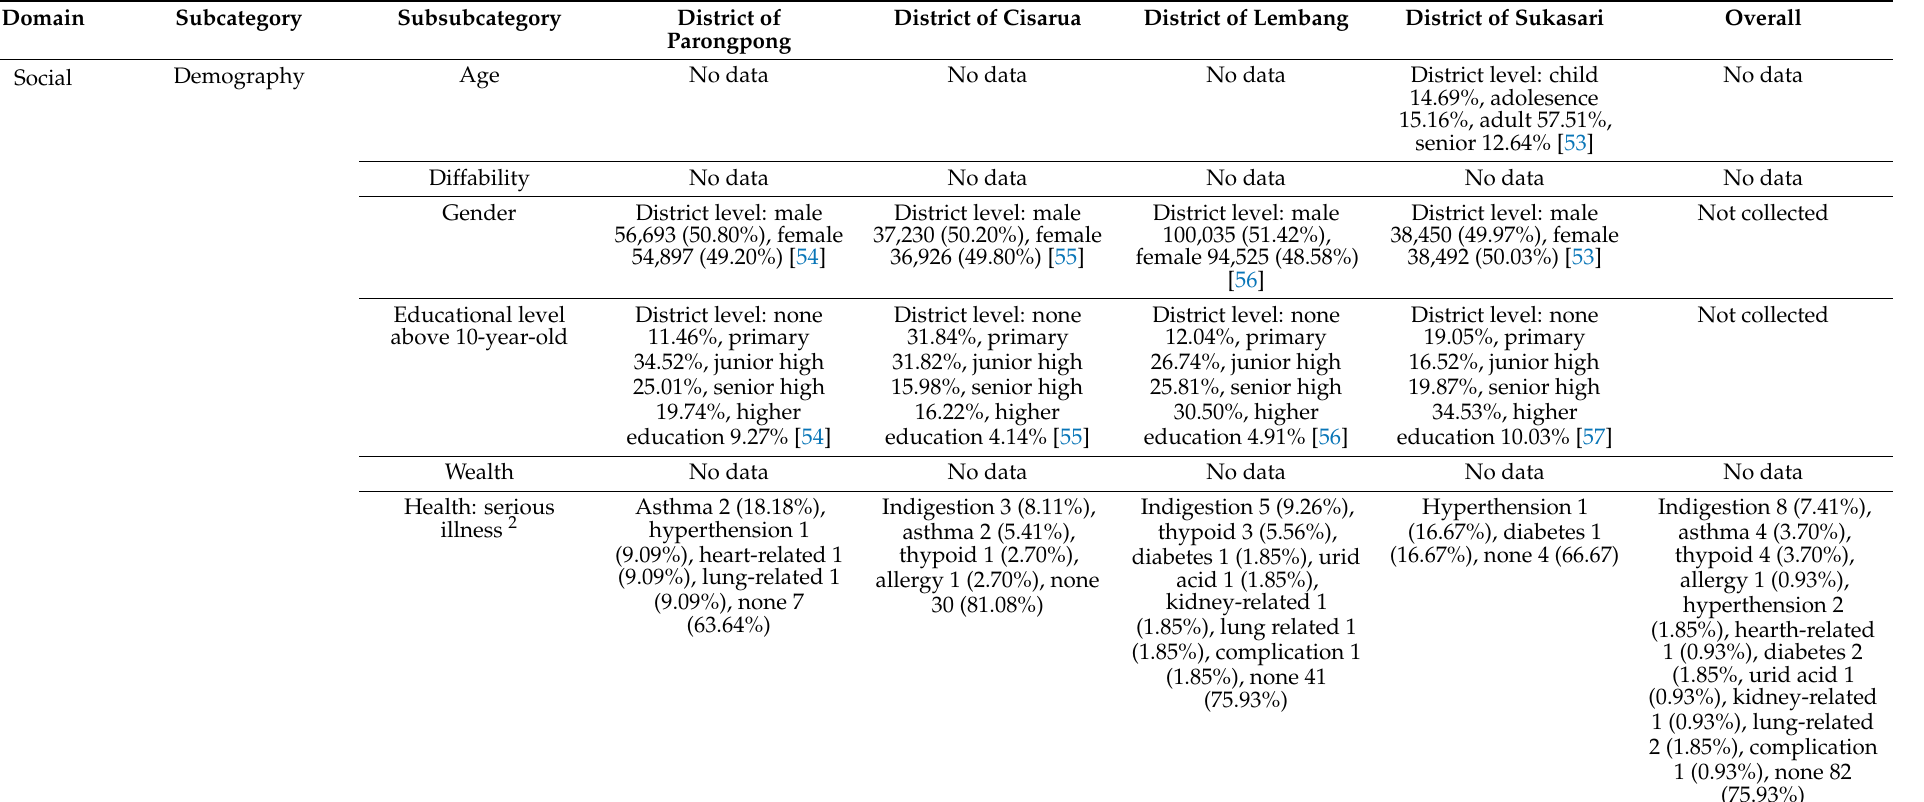
Table 1. The summary of the collected data 1